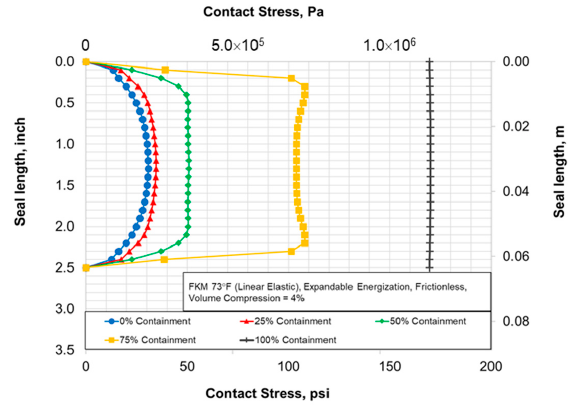
Figure 11. Contact stress profiles generated in expandable seal assembly at different amounts of seal containment.